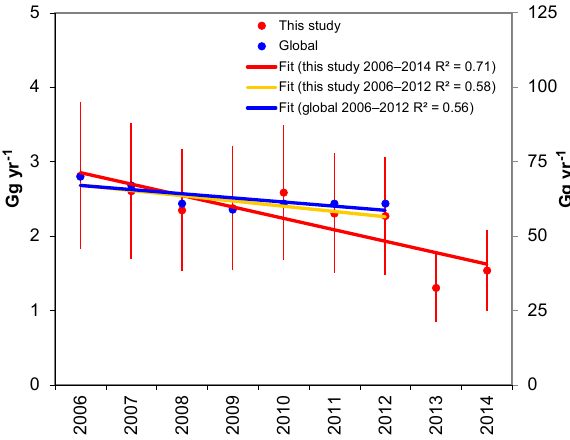
Figure 4. European geographical domain CCl 4 emission fluxes de- rived in this study (red dots, left axis) compared with the global ones reported in Carpenter et al. (2014) (blue dots, right axis). Red line: linear regression of our estimates during 2006–2014 ( − 6.9%yr − 1 ). Orange line: linear regression of our estimates during 2006–2012 ( − 2.9 %yr − 1 ). Blue line: linear regression of global fluxes during 2006–2012 ( − 2.2%yr − 1